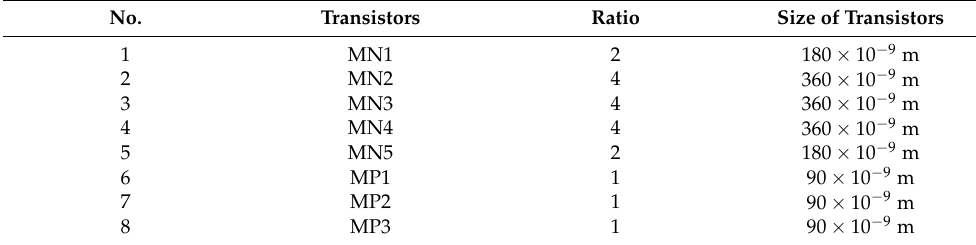
Table 4. Transistor size and ratio for bit cell configuration.